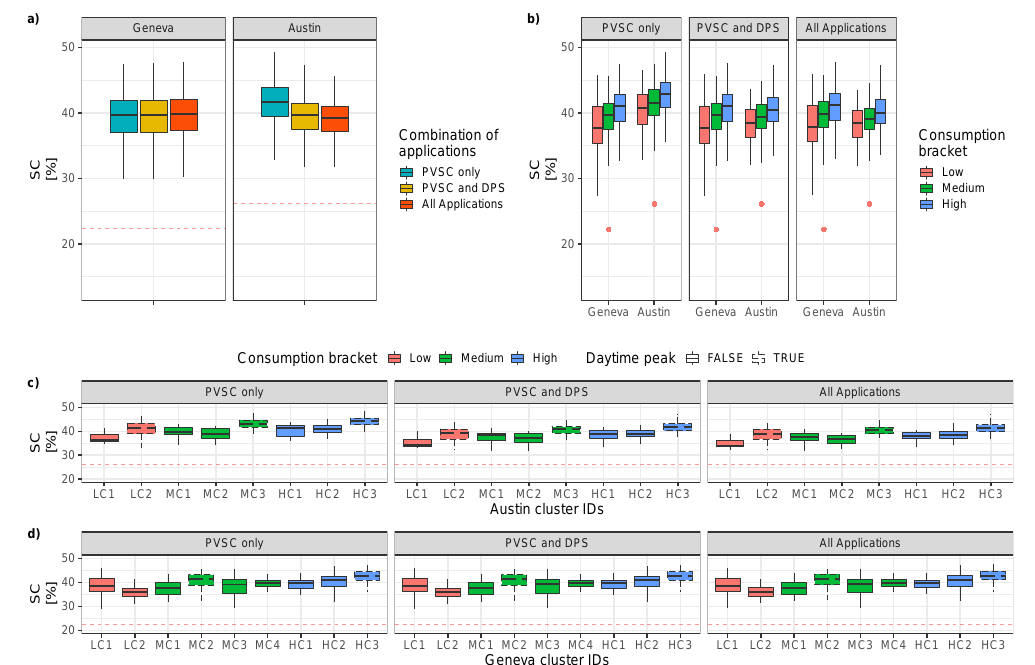
Figure 6. PV self-consumption (SC) of PV-coupled batteries. ( a ) Comparing the impact of the combination of applications per country; ( b ) Comparing the consumption bracket impact per country and per combination of applications; ( c ) Comparing the impact of the load profile (cluster) per consumption bracket and per combination of applications for Austin and; ( d ) Comparing the impact of the load profile (cluster) per consumption bracket and per combination of applications for Geneva. Dashed boxplots represent households with peaks during daytime (i.e., from 10 a.m. to 6 p.m.). The number of observation per cluster is indicated on top of the boxplots. The red dashed lines and red points represent the median SC of the same PV system without battery support. PVSC stands for PV self-consumption and DPS for demand peak